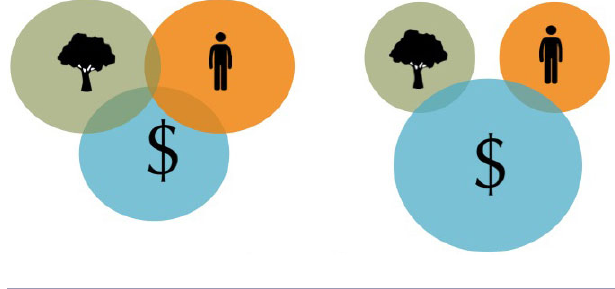
Fig. 1 . The social, environmental, and economic pillars often associated with sustainable development and “triple bottom line” thinking (a) has often led to trade-off decisions that either neglect the social-ecological, or strongly favor the economic (b). llustration: Jerker Lokrantz, Azote, for Stockholm Resilience Centre.